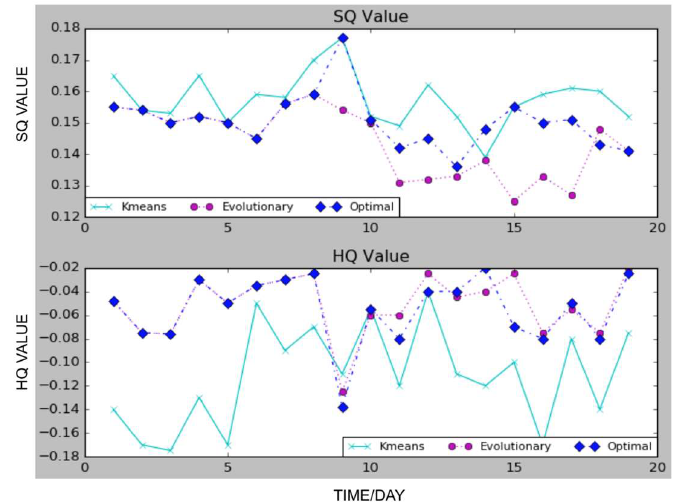
Table 1. Quality comparison.